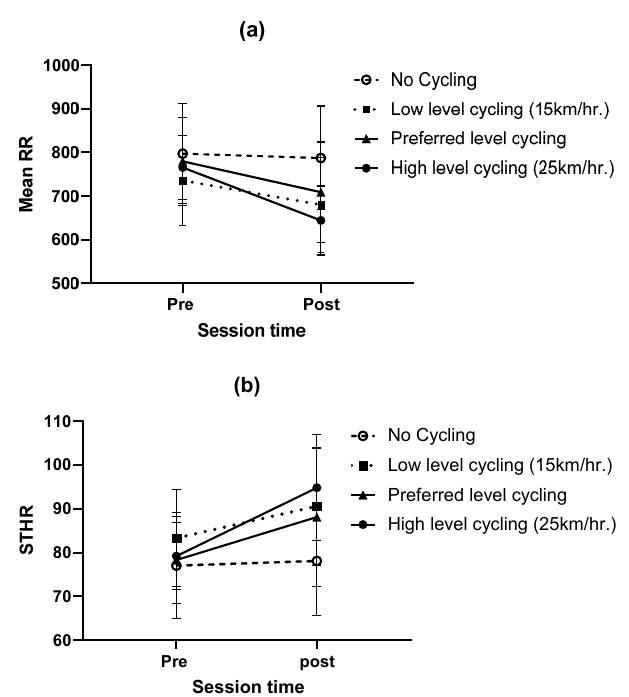
Figure 4. Interaction effects between the session and the assembly methods on: ( a ) mean interbeat (R-R) and ( b ) standard deviation of heart rate (SDHR).